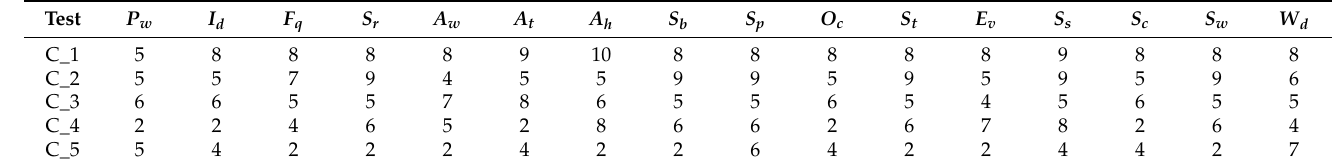
Table 6. Orthogonal test parametric arrangement for sprinkler drip irrigation in chernozem